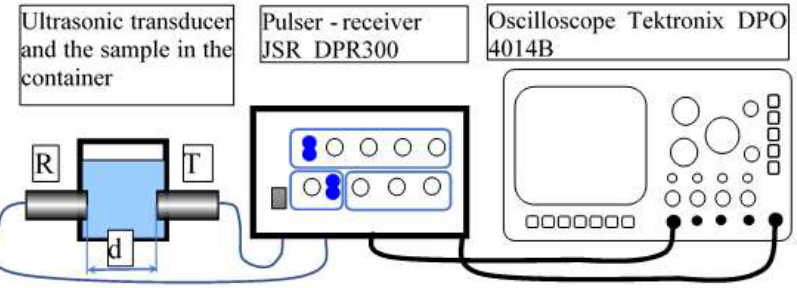
Figure 1. Experimental setup schematic: transducer, pulser-receiver, and oscilloscope.